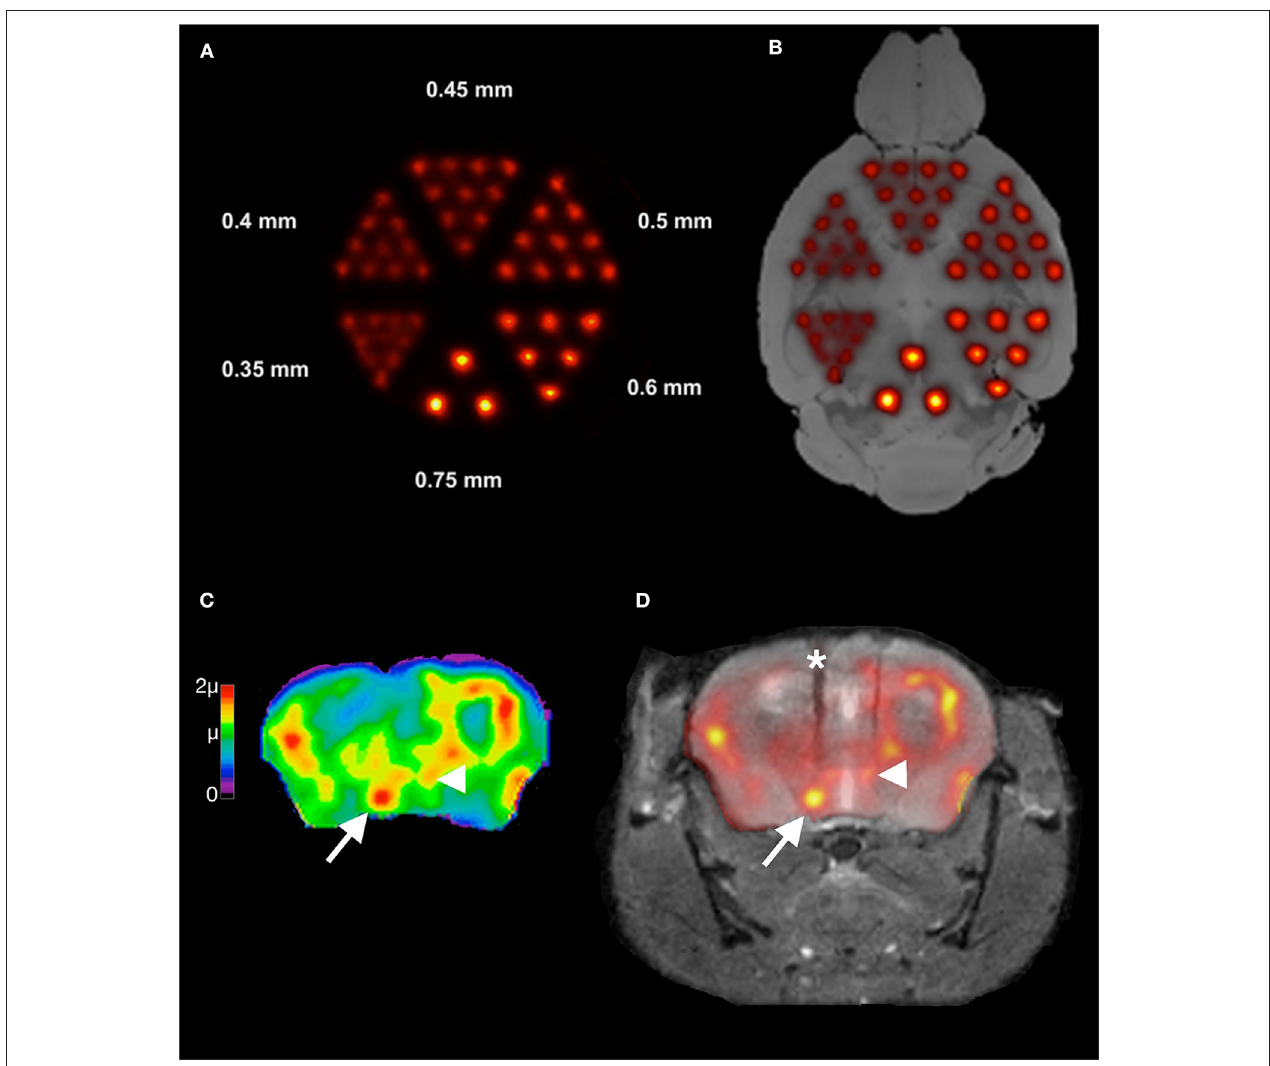
FIGURE 3 | Illustration of spatial resolutions with multi-pinhole SPECT imaging in mouse brain. Shown in (A) is an image of a SPECT measurement of a micro-Jaszczak hot-rod resolution phantom filled with 99m Tc. The phantom was scanned with custom-made 0.3mm multi-pinhole apertures at the Leibniz Institute for Neurobiology. Rods down to the size of 0.4mm can be resolved. In (B) , an overlay of the image in (A) onto an anatomical reference MR image [ 38] of a mouse brain is shown to illustrate these spatial resolutions in relation to the mouse brain anatomy. Resolutions in the range of 0.75mm that can easily be achieved in SPECT imaging are already quite useful for imaging brain regional tracer distributions. In (C) a high-resolution 99m Tc-HMPAO SPECT image is shown from the CBF of a mouse during intracranial self-stimulation of the medial forebrain bundle (mfb). This image was overlaid on the MR of the same animal in (D) . The MR is a post-mortem MR after removal of the self-stimulation setup. The electrode track is marked by an asterisk in (D) . Images were taken with the same setup as for the measurement in (A) . The color scale in (C) is in units of the global mean intensity µ . Note in (C) the clear delineation of the mfb (arrow) and the small hypothalamic region with a relatively high uptake